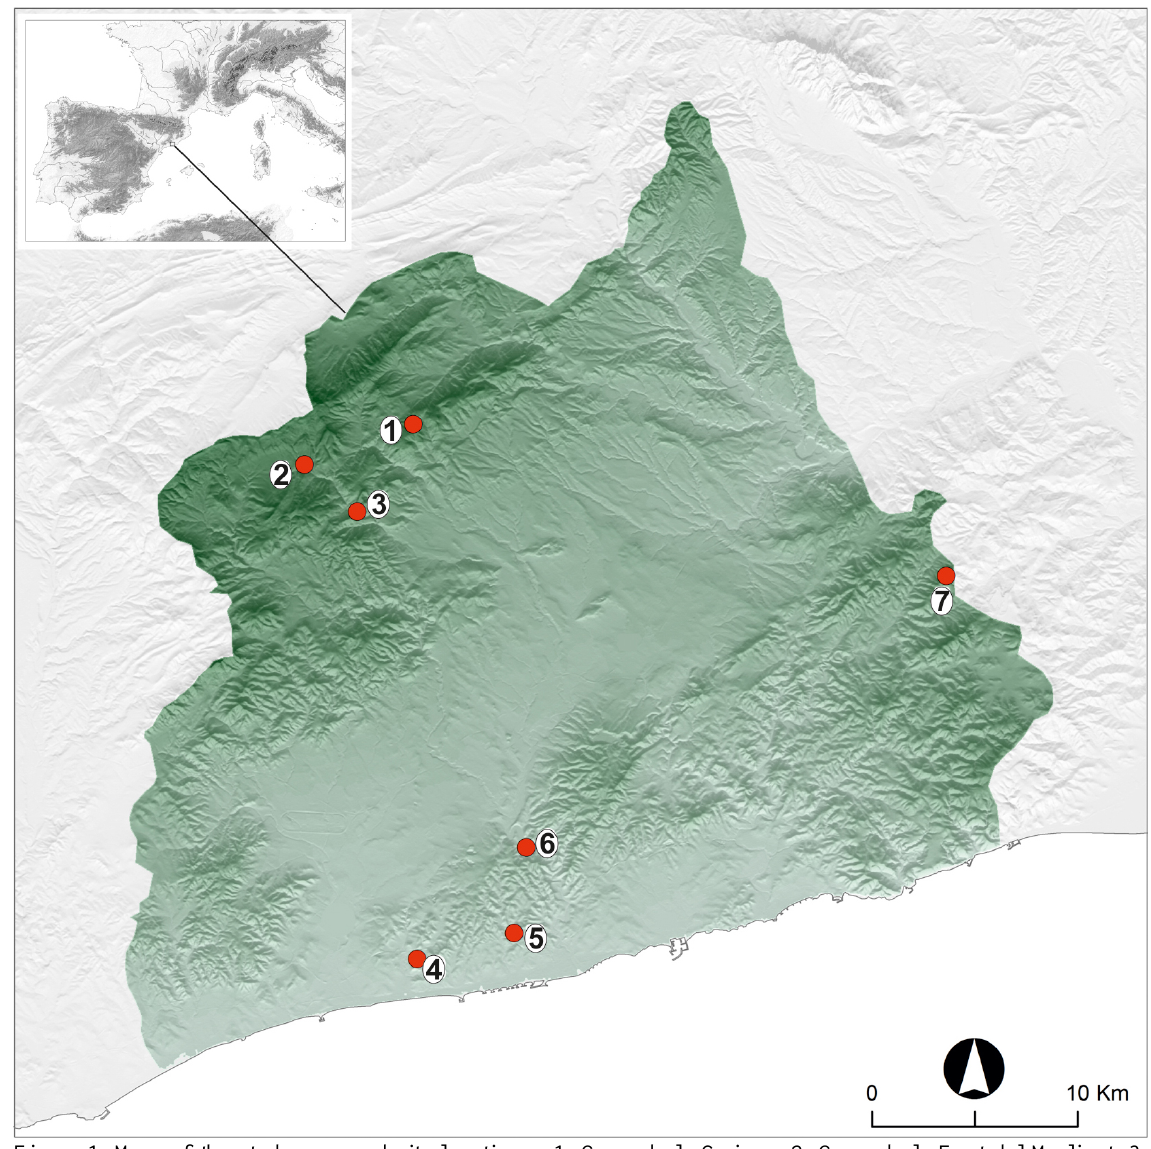
Figure 1. Map of the study area and site locations. 1. Cova de la Guineu; 2. Cova de la Font del Molinot; 3. Esquerda de les Roques del Pany; 4. Cova Foradada; 5. Avenc de Sant Antoni; 6. Cova del Pantà de Foix; 7. Cova de